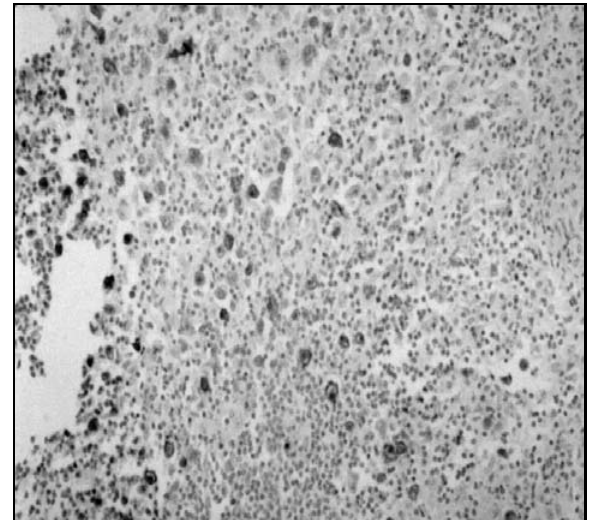
Figure 2 – Microscopic demonstration of EBV markers in classical Hodgkin’s lymphoma NS-subtype by immunohistochemistry (200x)